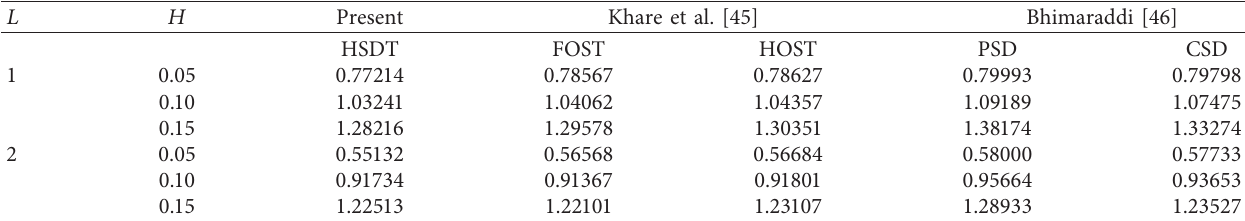
������� 􏽰 ( I ) / A of two-layered orthotropic shells under S-S boundary conditions is compared 0 11 ) 1/2 and Bhimaraddi [46]. 2